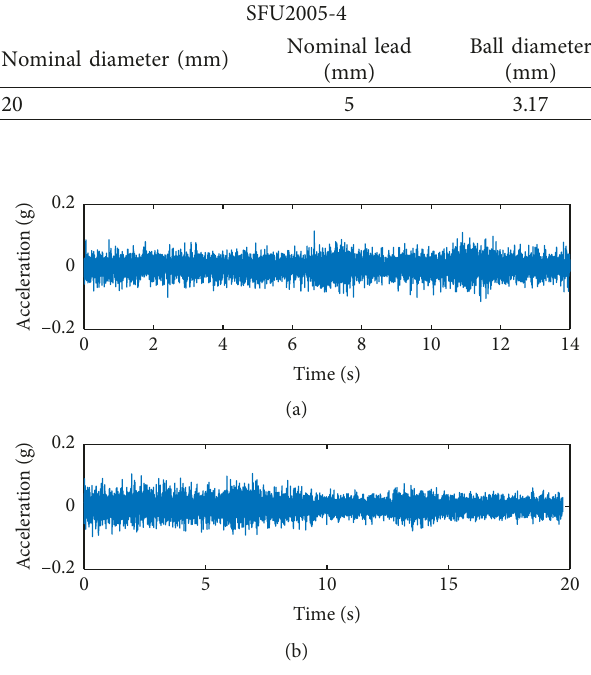
Figure 6: The vibration signals of two experiments. (a) Experiment 1. (b) Experiment